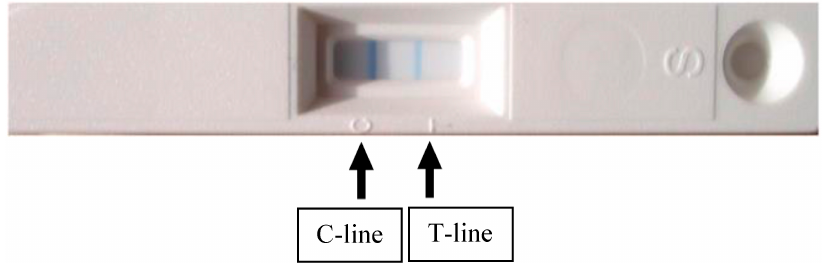
Figure 3. Two lines (Control line; C-line and Test line; T-line) due to elevated saliva aMMP-8 indicate elevated risk for periodontitis.